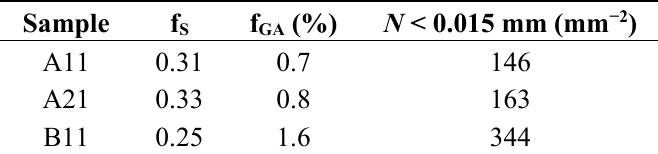
Table 3. Solid fraction and nodule count average values around the liquidus arrest in fields #10 to